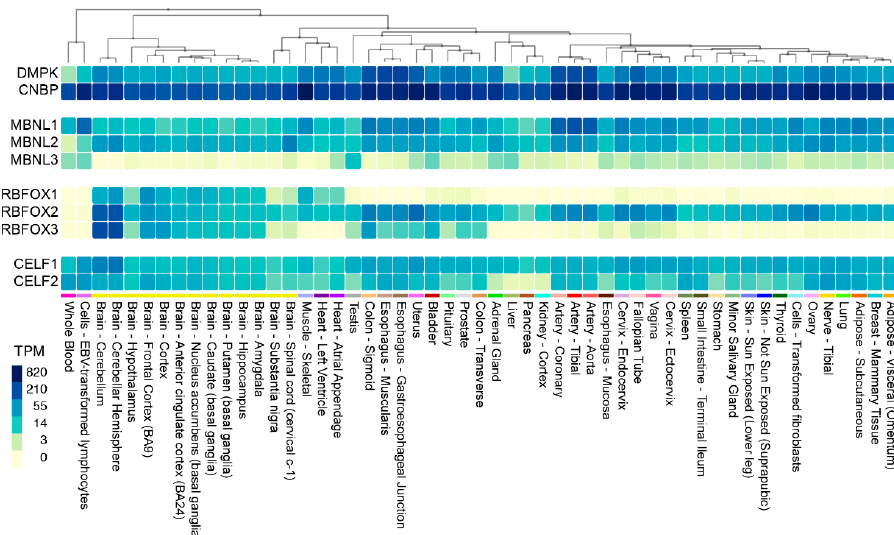
Figure 5. MBNL gene and ZnF structures. ( A ) Exonic structure and function of MBNL paralogs [135,148–150]. Exon enumeration is derived from previous studies [151]. ZnF1 / 2 and ZnF3 / 4–zinc finger domain pairs 1 / 2 and 3 / 4 respectively. NLS–nuclear localization signal. MBNL protein levels are shown as Low (bottom) and High (top) which trigger the indicated splicing events (black lines). ( B ) The structural model of MBNL1 zinc fingers (ZnF; blue) in complex with RNA (red) [152]. While DM1 and DM2 are classified as myotonic dystrophies characterized by myotonia, progressive myopathy and multiorgan involvement, they also have distinct clinical features [153]. DM2 is generally a later-onset disease with no congenital form and CNBP is expressed at much higher levels than DMPK (Figure 6). However, mis-splicing is usually less severe in DM2 compared to DM1 although the affinity of MBNL proteins for CCUG exp is higher than CUG exp [112,137,138]. What is the explanation for this discrepancy? Recently, RBFOX was shown to bind to CCUG exp but not CUG exp , RNAs and accumulate in RNA foci suggesting that MBNL-RBFOX competition for RNA binding sites selectively reduces MBNL sequestration in DM2 to promote more adult-like splicing patterns [154]. Similar to CELF and MBNL, the RBFOX proteins are also expressed in multiple tissues (Figure 6). DM2 appears to have distinct cell-specific molecular signatures that differ from DM1, including no detectable MBNL1 sequestration in RNA foci and no mis-splicing of MBNL1 RNA targets in DM2 iPSC-derived cardiomyocytes [155]. Additionally, retention of CNBP intron 1 and nuclear export of the incompletely processed mRNA, occurs in multiple DM2 tissues suggesting that RAN translation